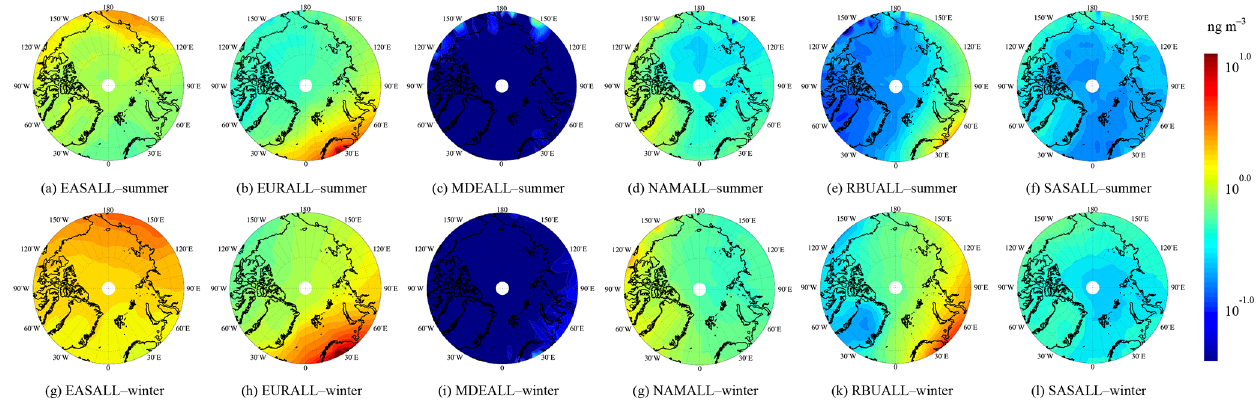
Figure 3. Spatial distribution of contribution of 20% emission reductions in different source regions to Arctic near-surface BC in summer and in winter in 2010.